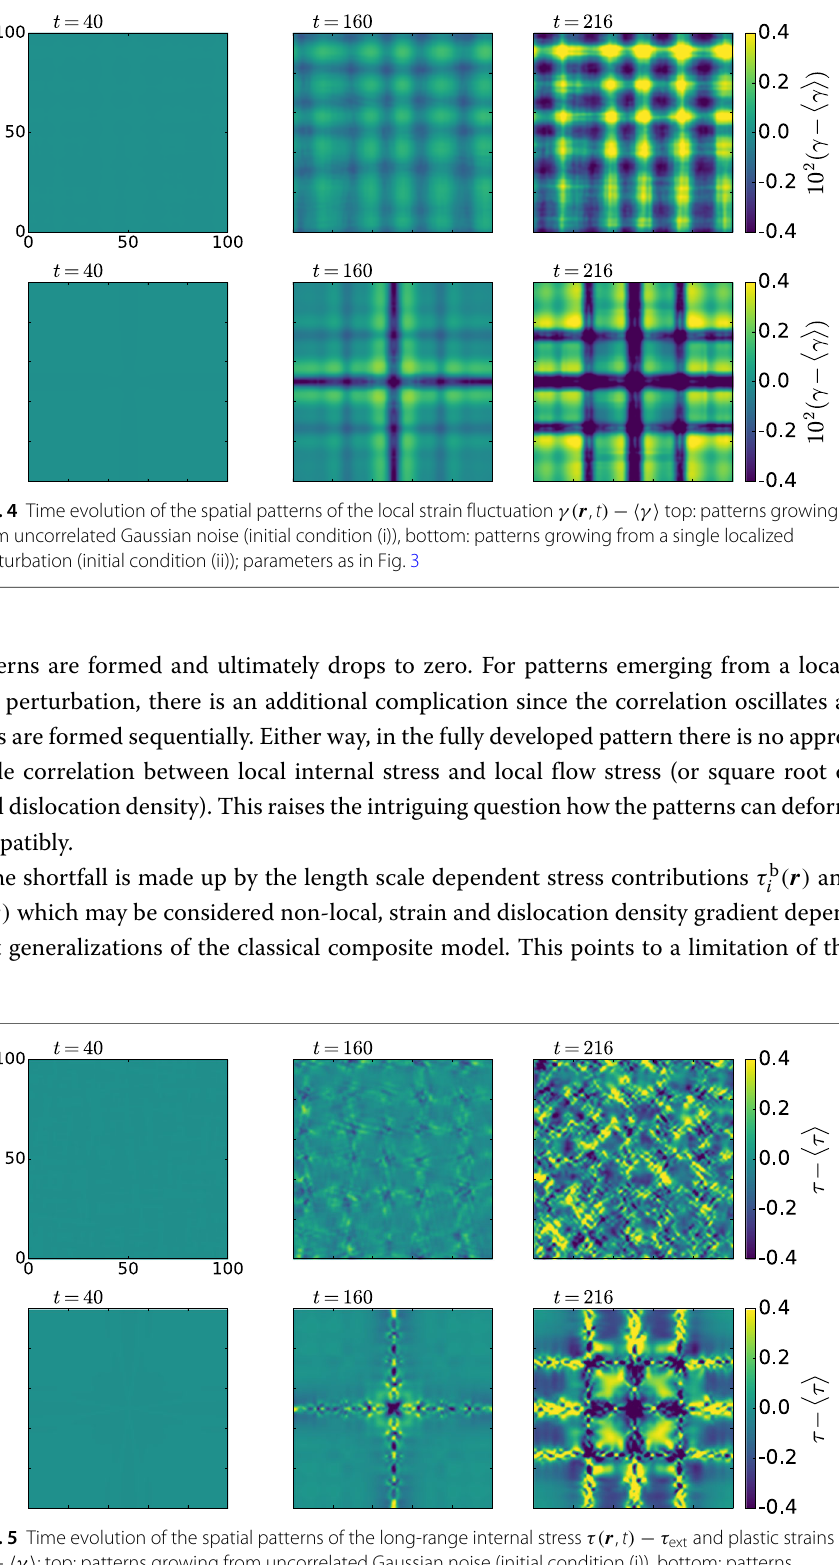
Fig. 5 Time evolution of the spatial patterns of the long-range internal stress τ( r , t ) − τ ext and plastic strains γ − (cid:14) γ (cid:15) ; top: patterns growing from uncorrelated Gaussian noise (initial condition (i)), bottom: patterns growing from a single localized perturbation (initial condition (ii)); parameters as in Fig.